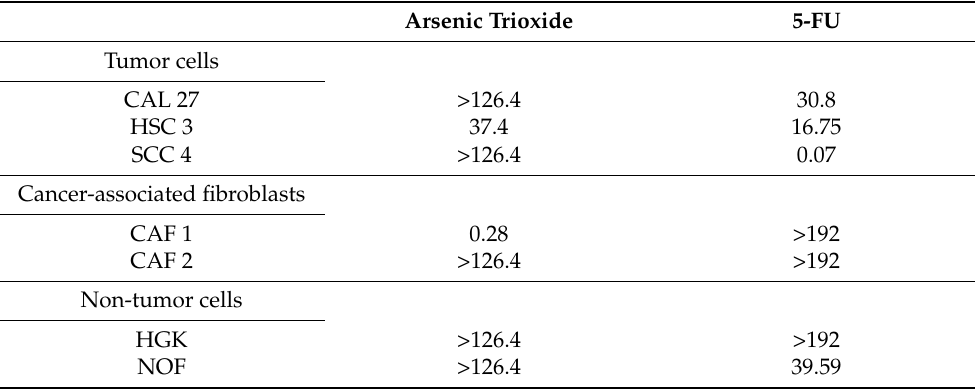
Table 1. The cytotoxic activity of Arsenic Trioxide and 5-FU in tumor and non-tumor cells. The data presented as IC 50 values corresponding to µ M (micromolar) by non-linear regression analysis of three independent experiments performed in duplicate (Alamar Blue assay, 72 h of